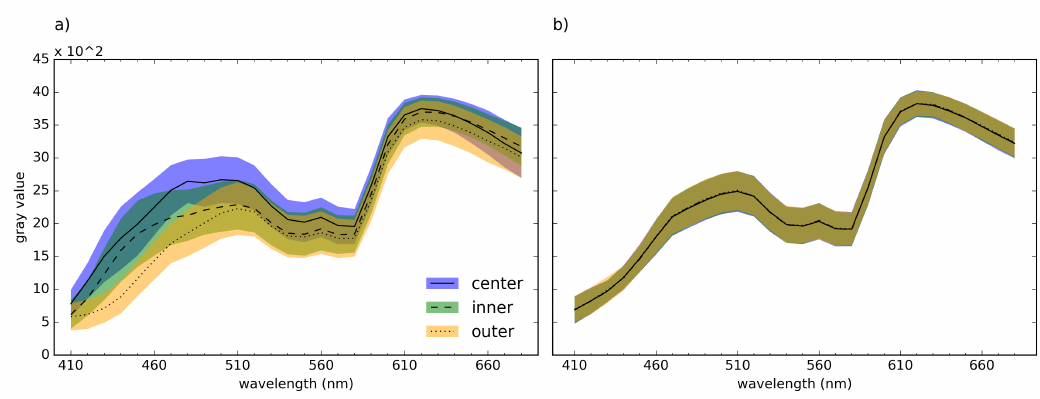
Figure 8. Mean and standard deviation of spectra from healthy tissue extracted from the center, the inner and the outer pixels of 800 honeycombs ( a ) before and ( b ) after pattern